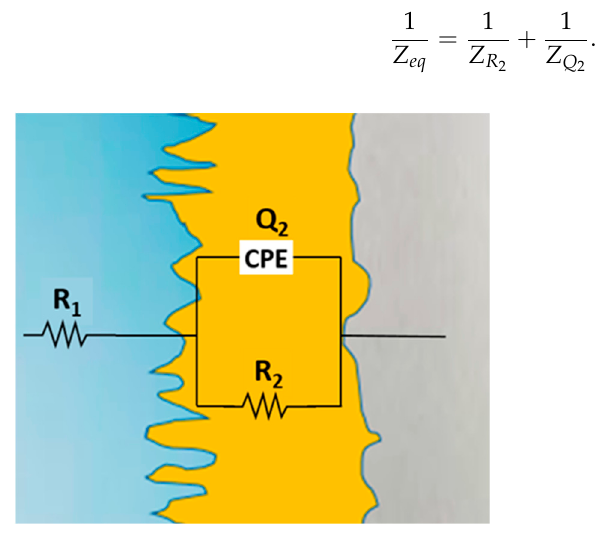
Figure 7. Bode diagrams for Sample 1 and Sample 2.